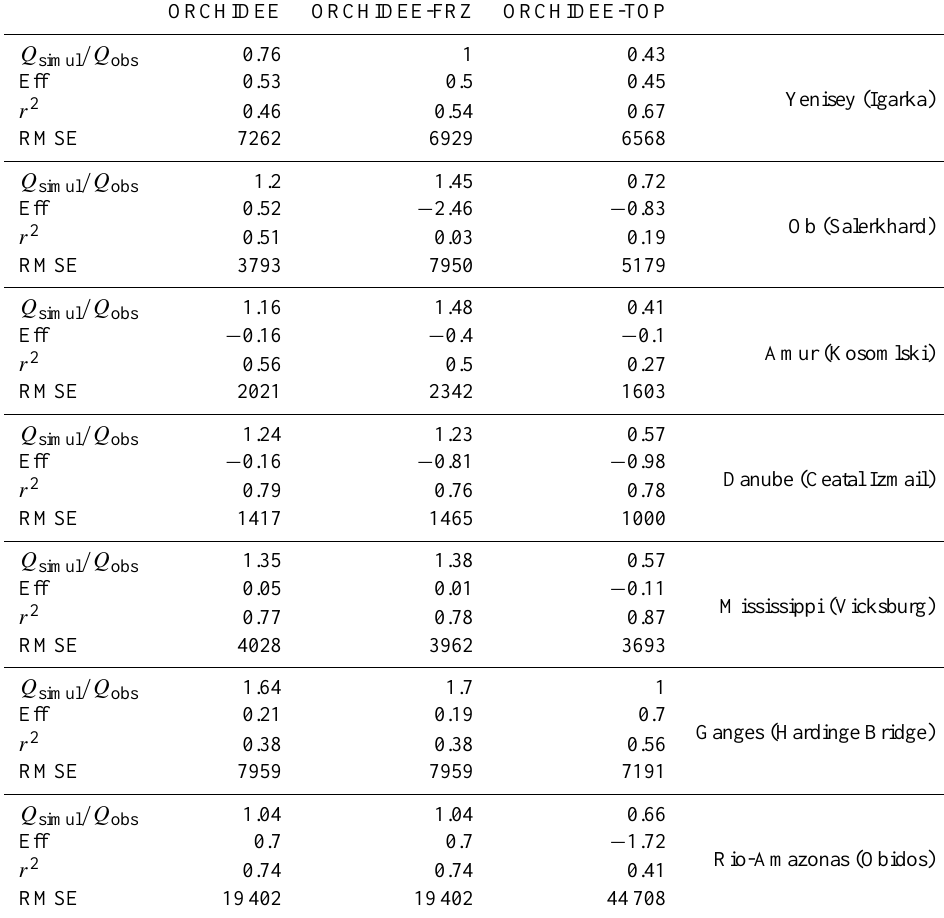
Table 2. Skill score for simulated discharges by ORCHIDEE (black), ORCHIDEE-FRZ (green) and ORCHIDEE-TOP (red) over the 7 rivers given in Fig. 3. The ratio between simulated and observed annual mean discharges ( Q sim /Q obs ) and the monthly efficiencies (Eff) (calculated over the whole discharge observation period given in Fig. 4, right panel) are given as well as the correlation ( r ) and RMSE (in m 3 s − 1 ) between simulated and observed monthly anomalies. ORCHIDEE ORCHIDEE-FRZ